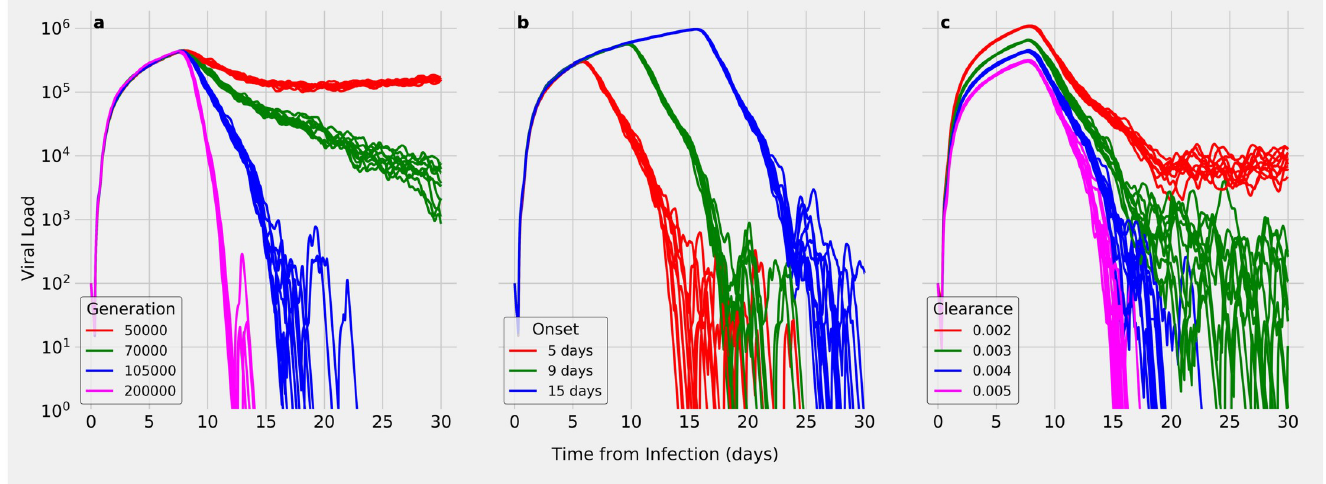
Fig 4. Effect of varying key immune response simulation parameters. Each subplot varies one parameter while holding others at the default values (Table 2) and shows the results of 10 random runs. (A) Varying T cell generation rate from 50,000 to 200,000 T cells produced per minute; (B) varying T cell delay; (C) varying viral clearance